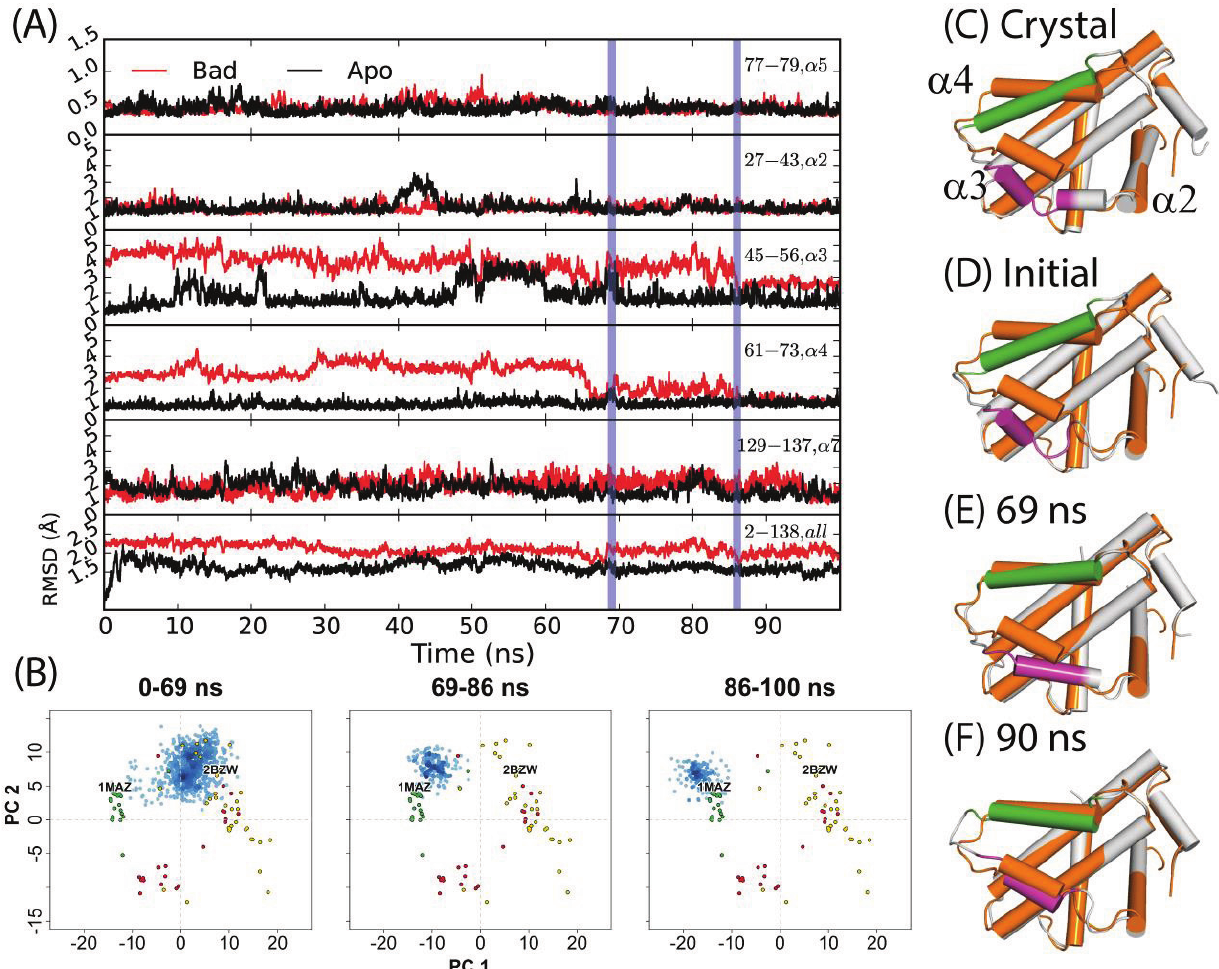
Figure 2. ( A ) RMSDs of α 2, α 3, α 4, α 5, α 7, and the full-length protein for a 100 ns simulation starting from the Bad-bound structure (red) and the apo structure (black). The former saw a relaxation to an apo-like state after 86 ns, with key transition points indicated by vertical blue lines. ( B ) Specific portions of the trajectory corresponding to different time intervals were projected into the experimental structure PC subspace (blue points) for comparison to the RMSD analysis. ( C ) Crystal structures of apo- and Bad-bound Bcl-xL were aligned to depict the end states. Corresponding conformations at ( D ) 0 ns, ( E ) 69 ns, and ( F ) 90 ns are shown. For ( C – F ), the reference apo Bcl-xL structure is colored in orange. For the aligned conformations, the purple and green segments denote α 3 and α 4 helices along with other Bcl-xL segments colored